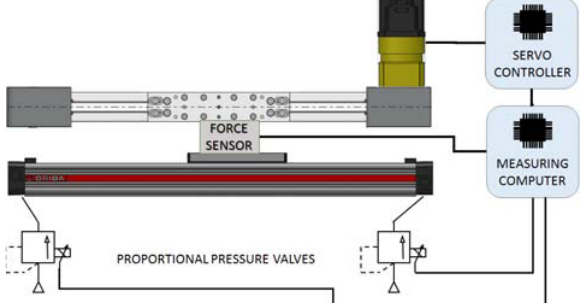
Fig. 7. Test rig for the friction force of pneumatic drive under pressure measurements .